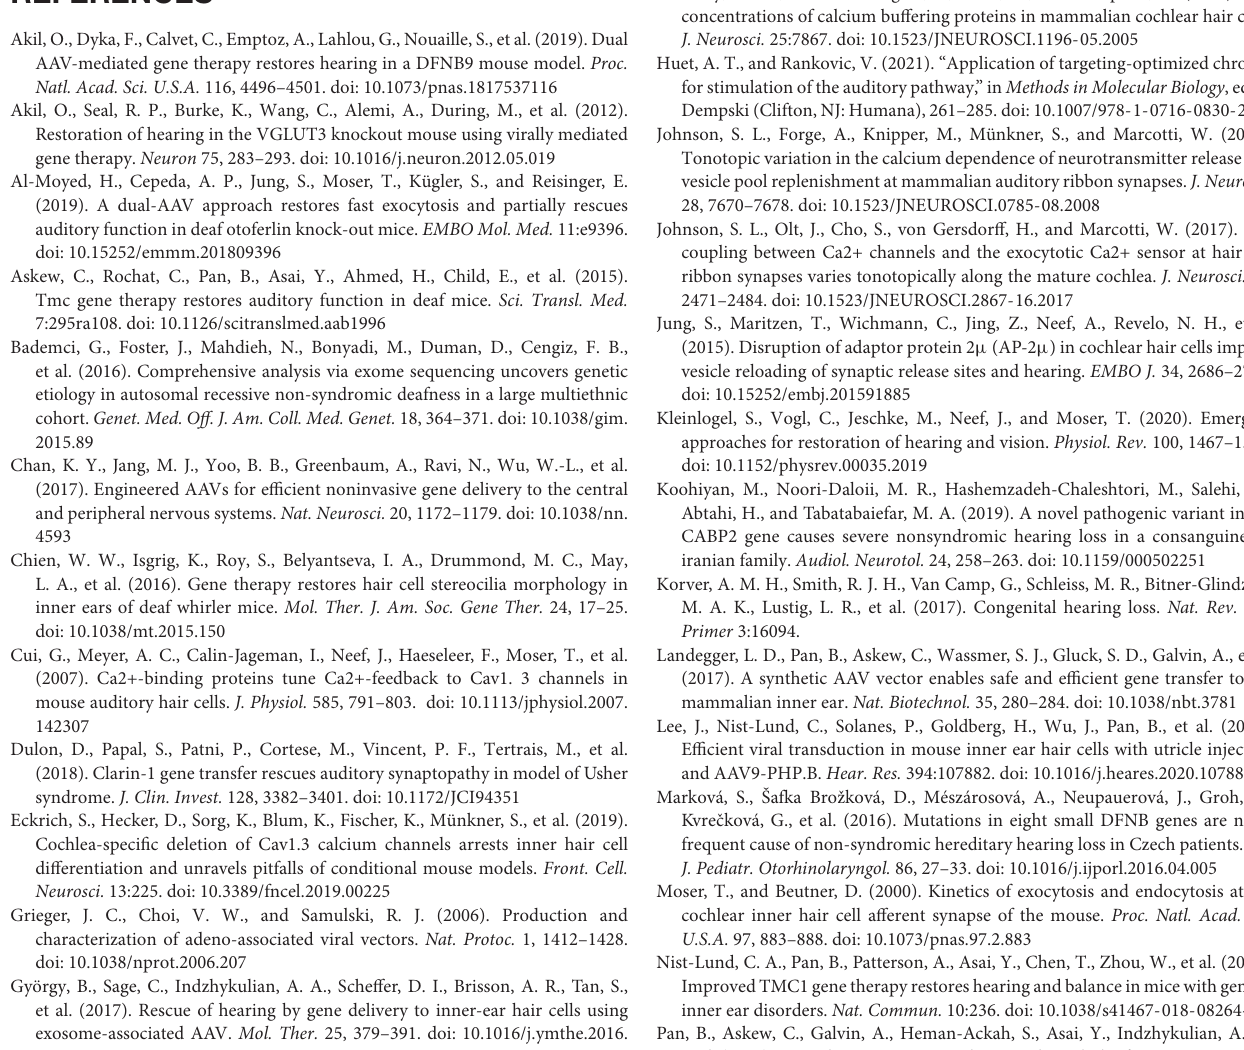
Supplementary Figure 1 | Calcium-binding protein 2 ( Cabp2) -P2A- eGFP construct assembly and pAAV vector used for AAV packaging of Cabp2 -P2A- eGFP . pAAV cis- plasmid providing Cabp2 and eGFP with a P2A peptide sequence for bicistronic expression of the two proteins. Asterisks denote impaired ability of the restriction enzyme to cleave at the restriction site. Supplementary Figure 2 | ABR responses and eGFP expression in AAV2/1- Cabp2 -injected animals. (A) Reconstructions of native eGFP fluorescence of AAV2/1- Cabp2 -injected organs of Corti observed under a fluorescence microscope. An almost continuous line of eGFP fluorescence in IHCs is observed. Please note that the fluorescence can not be observed where a nylon grid crosses the explants. (B) Mean ABR thresholds of AAV2/1- Cabp2 -injected Cabp2 − / − vs. non-injected Cabp2 − / − animals. Hearing was improved for 6 and 12-kHz tone bursts (two-way ANOVA with Šidak’s multicomparisons test). (C) ABR wave II-V amplitudes in injected and contralateral, non-injected ears of AAV2/1- Cabp2 -injected Cabp2 − / − animals to an 80-dB 20-Hz click stimulus. Note increased amplitudes of injected ears for waves II, III, and IV (Šidak’s multicomparisons test, p < 0.001 for wave II and III, and < 0.0001 for wave IV). Asterisks denote p -values of less than 0.05.